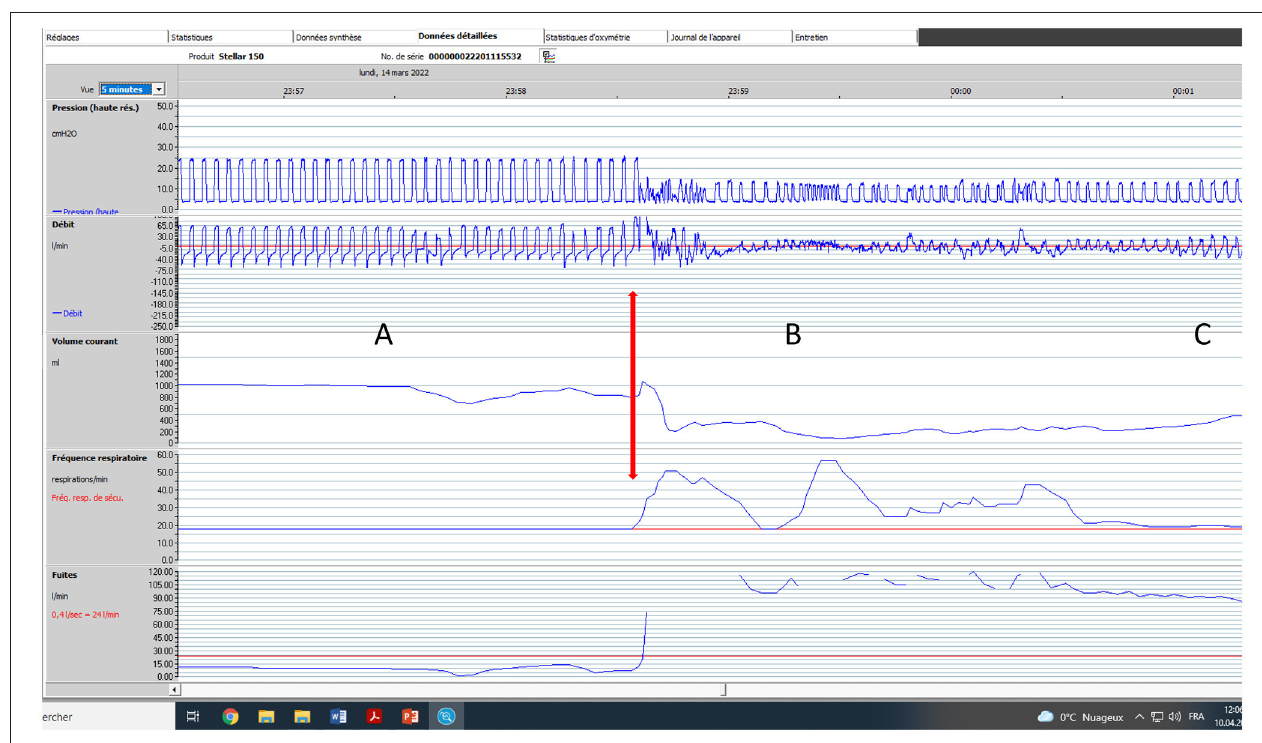
FIGURE 5 | Impact of major leaks. Seventy five-year old male subject with severe COPD (GOLD D; FEV1: 17% of predicted). Bi-level pressure support ventilator, S/T mode (spontaneous/timed); IPAP (Inspiratory positive airway pressure): 24 cmH 2 O; EPAP (Expiratory positive airway pressure): 4 cmH 2 O; Back-up respiratory rate (BURR): 18 cycles/min. Facial mask. Five-minute window, Rescan software, ResMed. (A) normal tracing albeit for a few cycles with decrease in flow; (B) Vertical arrow marks appearance of major leaks (could be related to transient displacement of interface). Pressure tracing shows episodes of auto-triggering, and double triggering. Marked drop in pressure, flow and V T (explained by magnitude of leaks). (C) As leaks progressively decrease, breathing pattern becomes more regular; pressure and flow increase